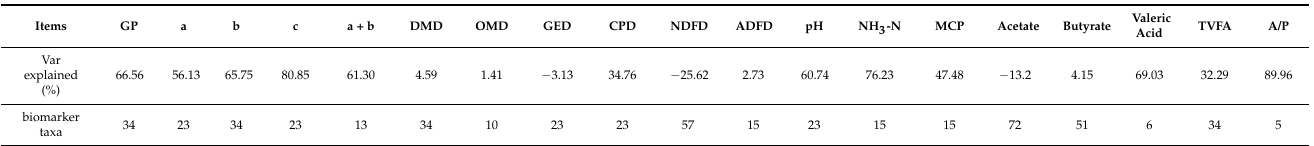
Figure 2. Prediction of propionic acid by rumen bacterial community based on random forest machine learning algorithm. Table 7. Prediction of the in vitro fermentation parameters by rumen bacterial community based on random forest machine learning algorithm.